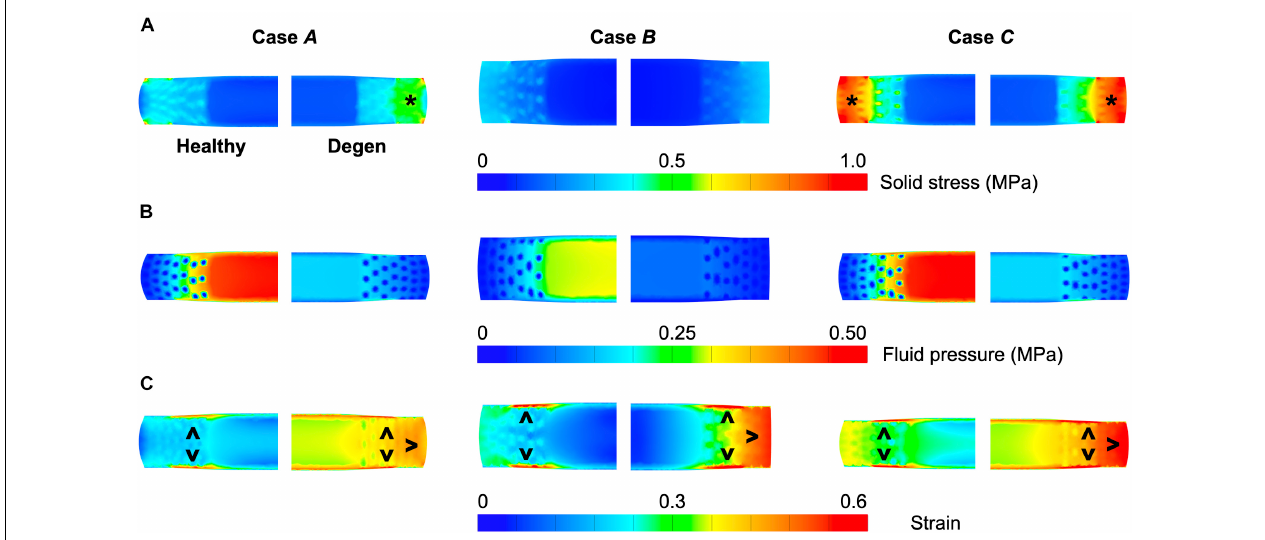
FIGURE 6 | Representative post-loading disc mid-frontal (or coronal) plane (A) solid stress, (B) fluid pressure, and (C) strain distributions in healthy and degenerated (Degen) disc models. Black asterisks highlight stress concentrations. Black triangles point at strain